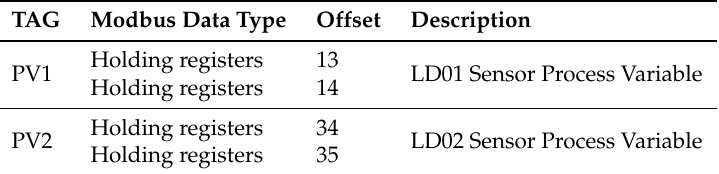
Table 2. ISA 100.11a gateway Modbus memory mapping.